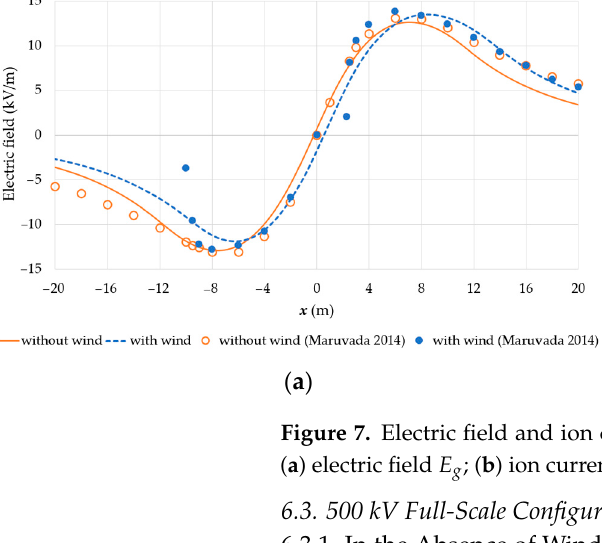
( b ) Figure 9. Ion current density distribution of the ±500 kV configuration with DMRC: ( a ) in the absence of wind; ( b ) in the presence of wind with average α . 6.3.2. In the Presence of Wind The steady wind velocity model described in Section 2.2 is applied with the annually average wind data, w r = 1.3 m/s and α = 0.4. The wind direction is from the negative to the positive conductors, as  g and J g peaks are higher [1]. Figure 10a compares  g of both configurations under the wind condition. The electric field in the figure is unsymmetrically distributed in the presence of the wind.  g decreases by 0.4 kV/m on the upwind side (negative voltage) and increases by 2.7 kV/m on the downwind side (positive voltage). As a result,  g peaks on the upwind and downwind sides are approximately − 9% and 63% of those in the no-wind condition, respectively. Note that the  g peak on the downwind side is higher than the peak of the HVAC lines. The positions of the  g peaks are shifted slightly by the wind condition. At the edge of ROW on the downwind side, the field is also significantly higher than that of the HVAC lines (by 6.9 times). Figure 9a shows that the DMRC considerably mitigates  g . The peak positions change to x = − 19 and 20 m, i.e., they are shifted farther from the center line ( x = 0). At the edge of ROW on the downwind side, the migration of  g by DMRC is mild. In conclusion,